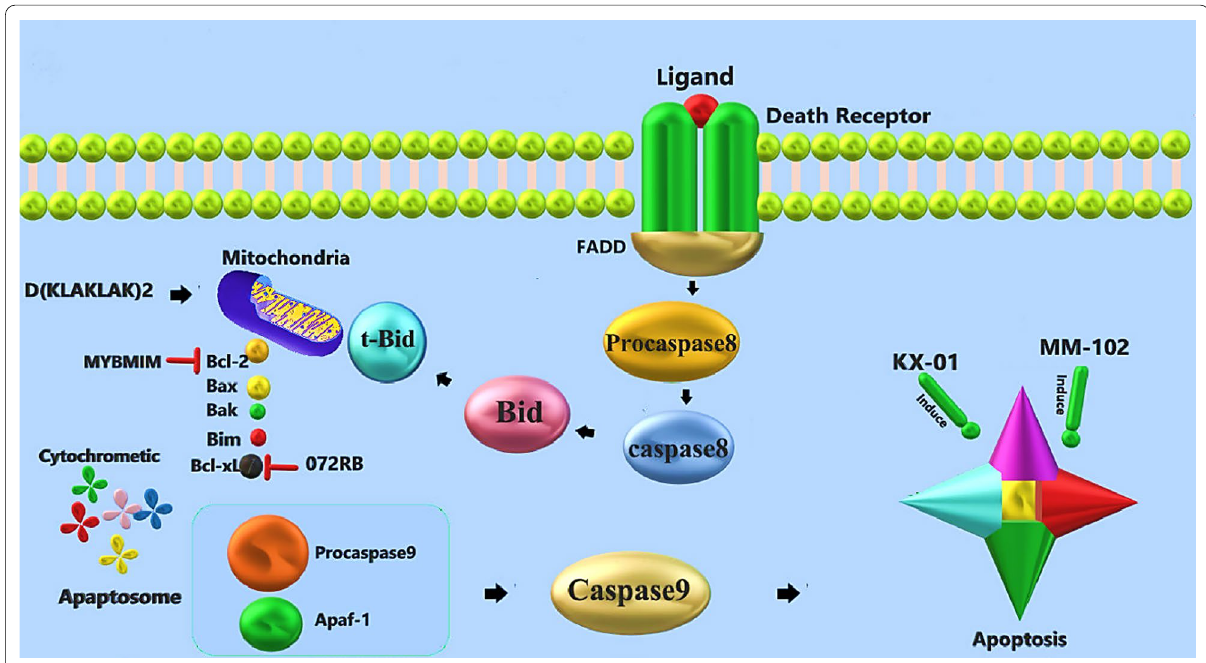
Fig. 3 Triggering apoptosis pathway using